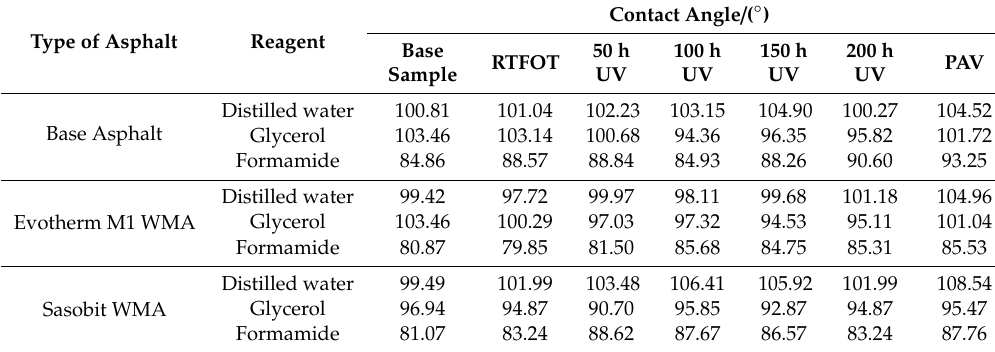
Table 4. Contact angle data of asphalt at 25 °C .